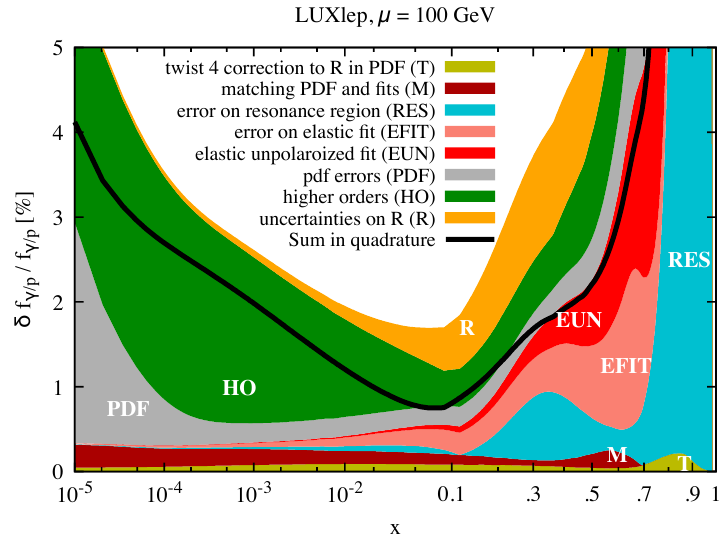
Figure 2. The relative uncertainties on the photon density, stacked linearly. The various entries are explained in the text. The black line is the sum in quadrature of all